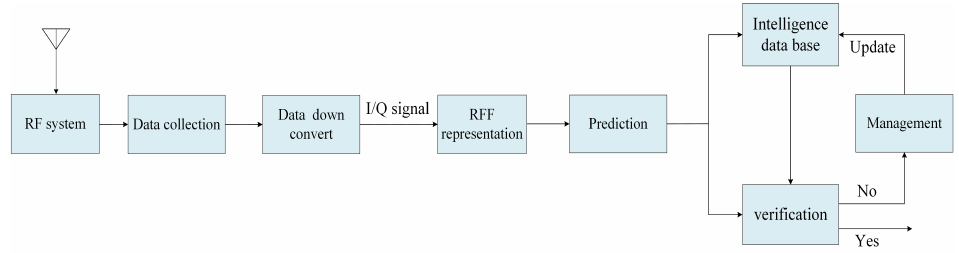
Figure 1. The architecture of a typical REC system, where radar signals are obtained by RF sys- tem, sampled by data collection and are processed by the backend RF representation as well as classification, which provides intelligence support and online update for